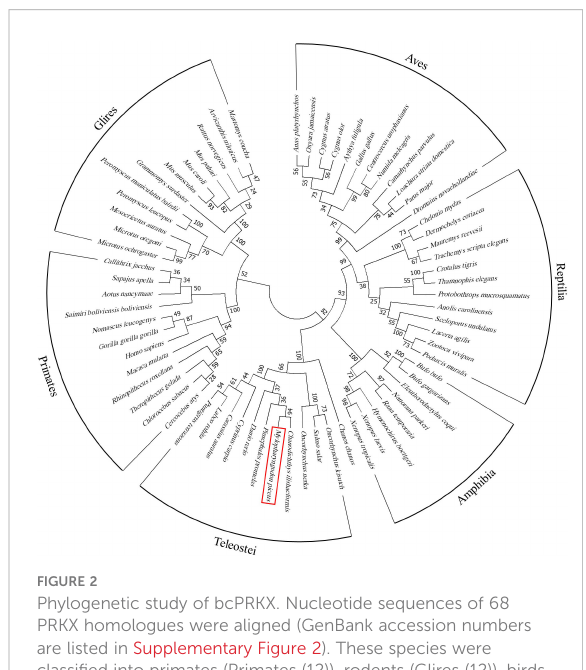
FIGURE 2 Phylogenetic study of bcPRKX. Nucleotide sequences of 68 PRKX homologues were aligned (GenBank accession numbers are listed in Supplementary Figure 2). These species were classi fi ed into primates (Primates (12)), rodents (Glires (12)), birds (Aves (12)), reptiles (Reptilia (12)), amphibians (Amphibia (8)) and fi sh (Teleostei (12)). The result of alignment was built into a phylogenetic tree by using MEGA